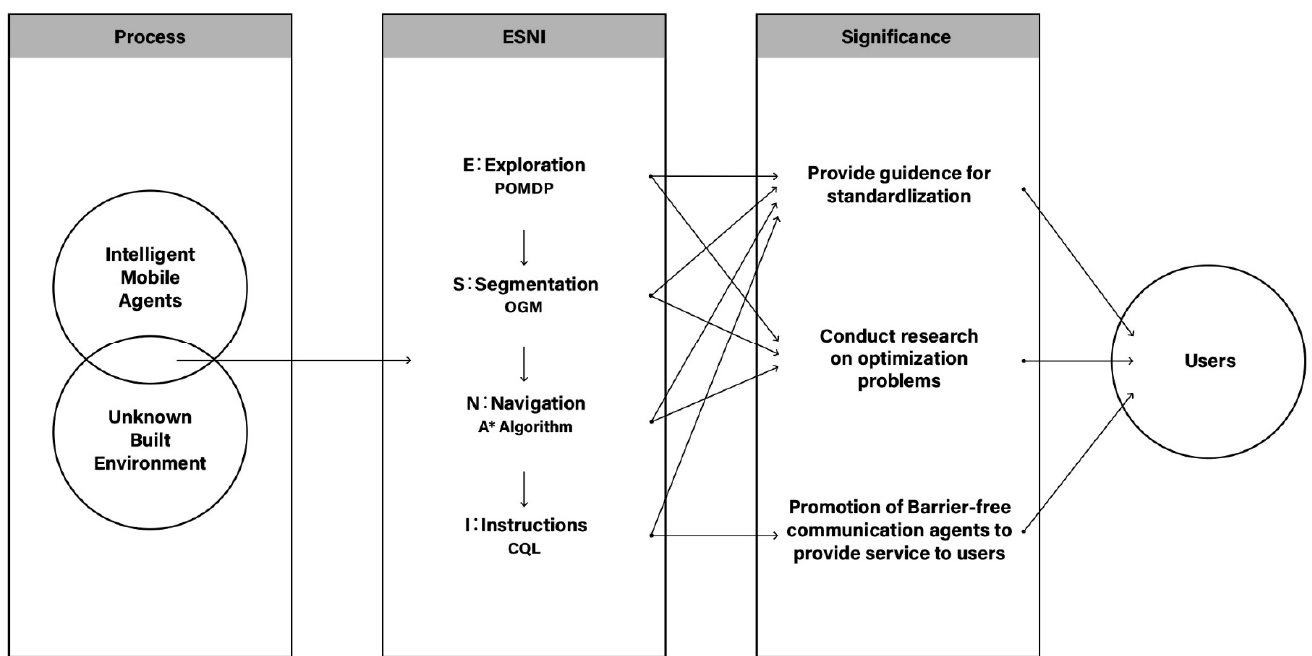
Figure 2. Theoretical framework.